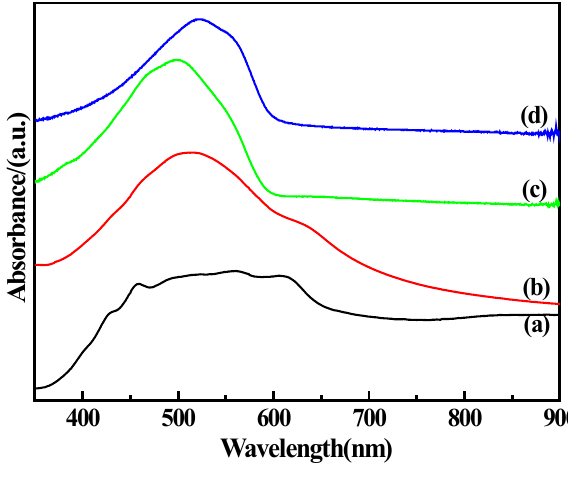
and ( d ) poly(TMPT)/TiO 2